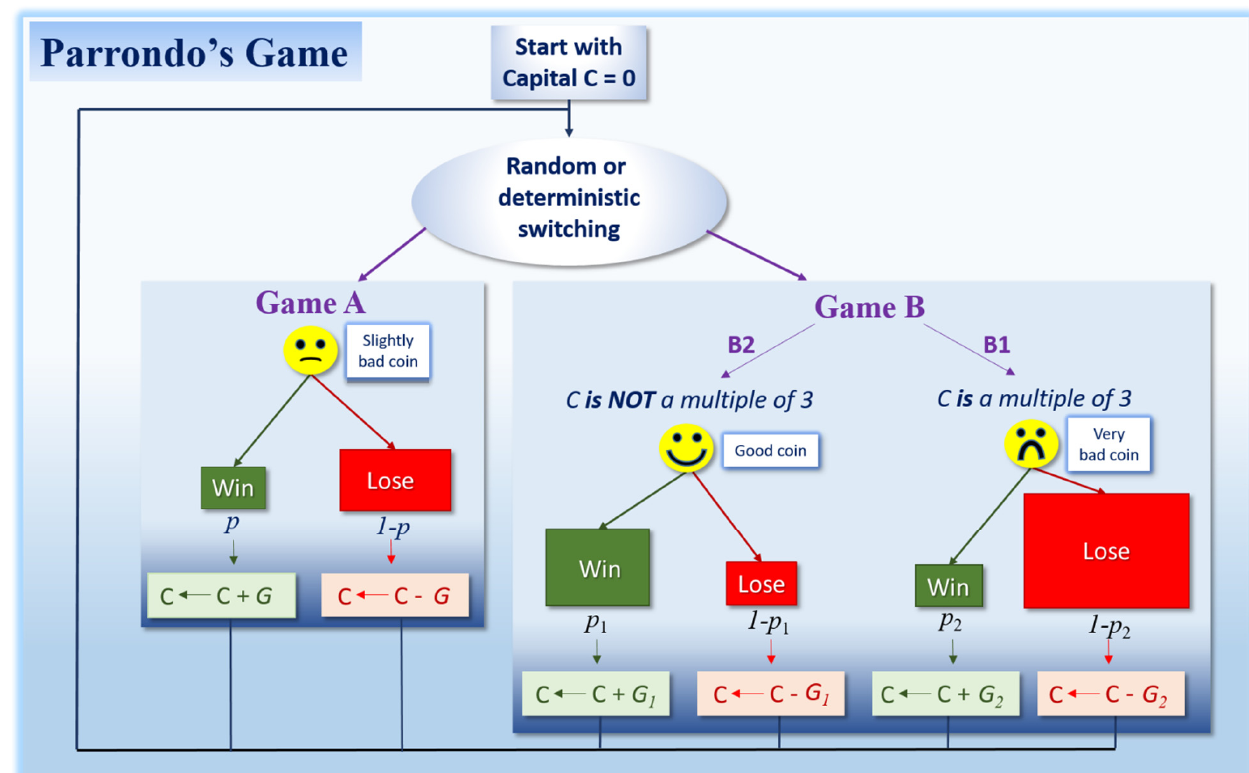
Figure 1. Parrondo’s original game, involving two games, A and B (adapted from [32] ). See Box 1 for details.